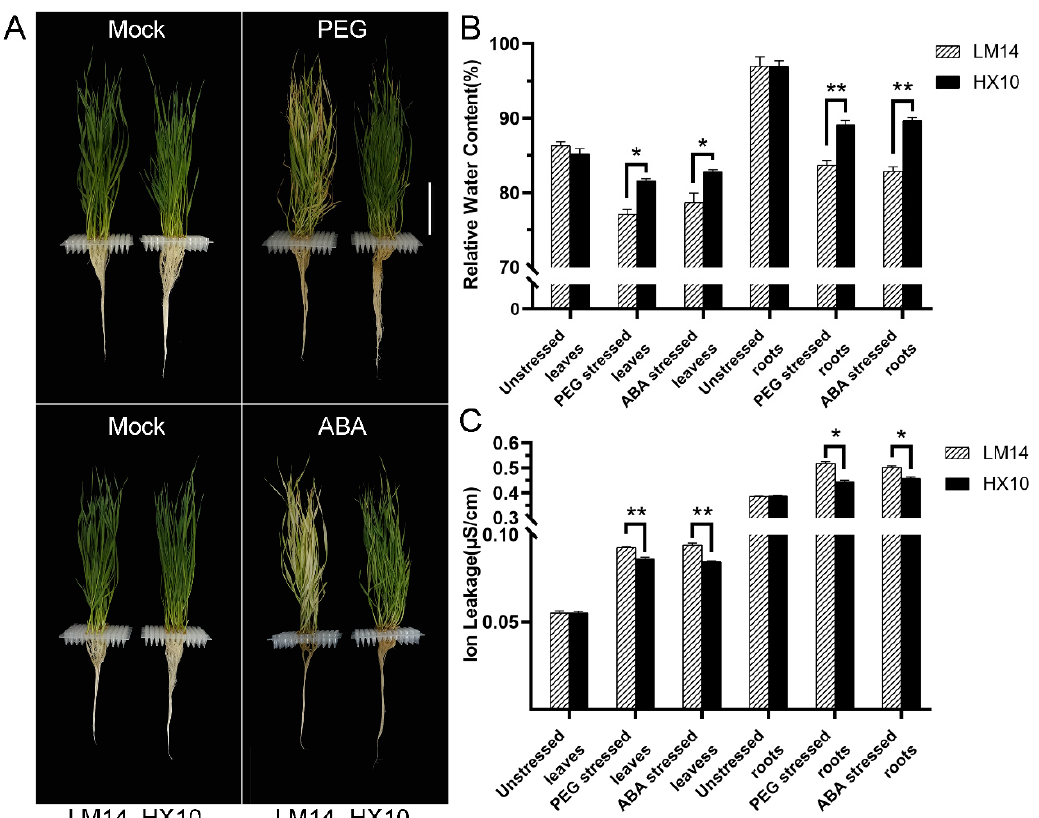
Figure 2. The phenotypic and physiological measurements of polyethylene glycol (PEG) and abscisic acid (ABA) responses in LM14 and HX10 cultivars. ( A ) Morphological features of seedlings before and after 5-day PEG, ABA, and Mock treatments. The relative water content ( B ) and ion leakage ( C ) values of leaves and roots of seedlings measured before and after 5-day PEG, ABA, and Mock treatments. The scale bar represents 10 cm. Error bars represent the means ± SD ( n = 3). * indicates p < 0.05; ** indicates p < 0.01.